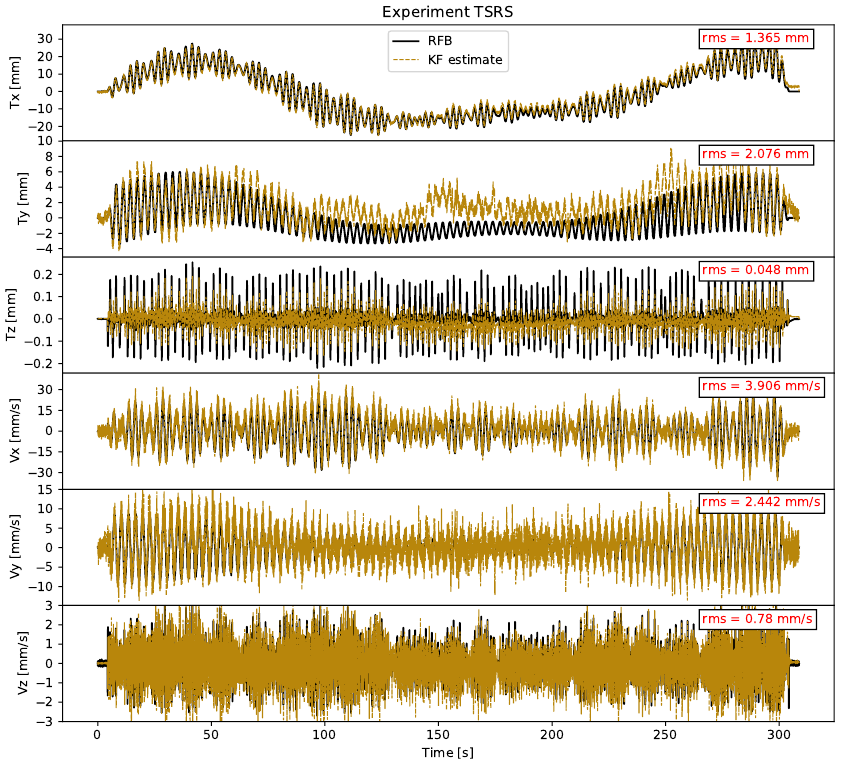
Figure A5. Time series of the full Kalman filter combination for experiment TSRS visualizing KF displacement and velocity estimates and the robot feedback